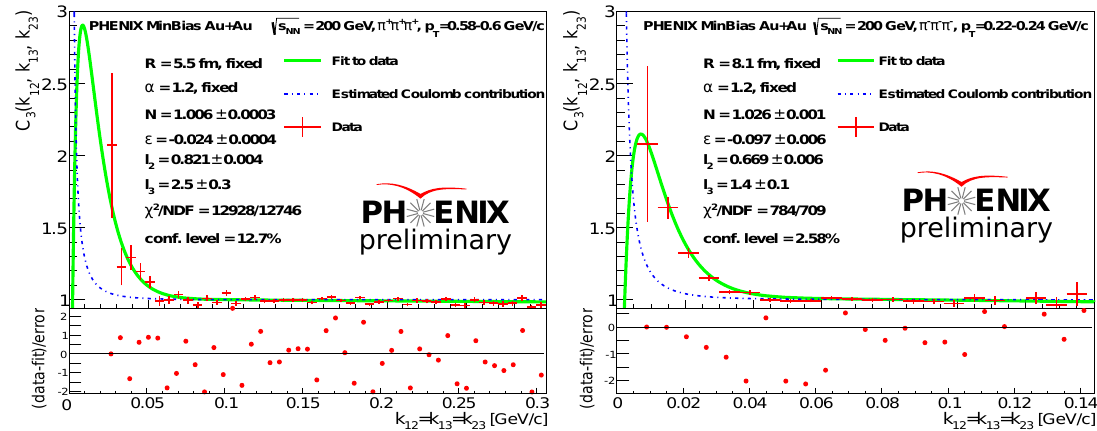
Figure 1. Diagonal visualization of the three-particle Bose–Einstein correlation functions C 3 with the results of fits.